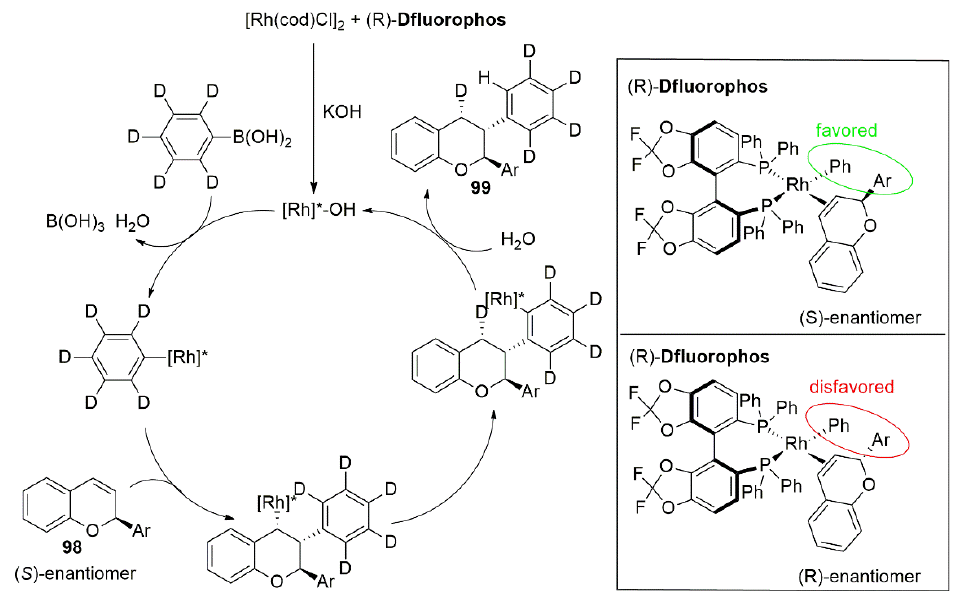
Figure 40. Rhodium-catalyzed hydroarylation of 2-aryl chromenes: Deuterium-labeling experiment and proposed mechanism.